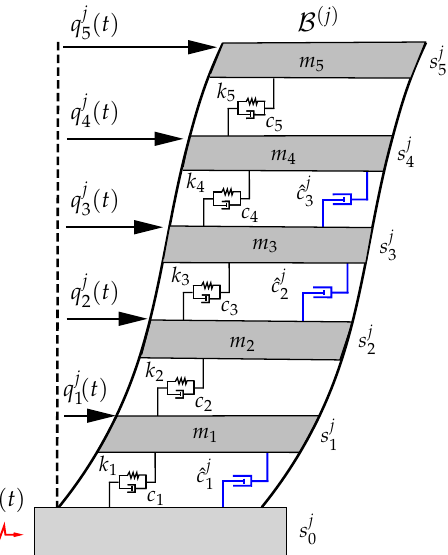
Figure 2. Schematic mechanical model of a five-story building equipped with a distributed system of ˆ n j = 3 supplemental interstory dampers implemented at the story levels ˆ p j